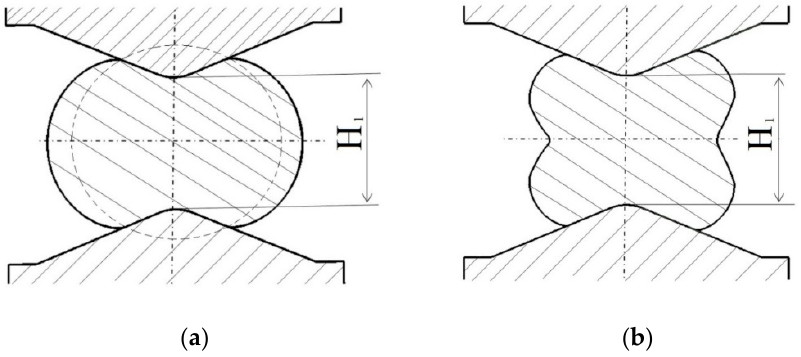
Figure 4. Order of forging the workpiece with convex anvils ( α c = 135°, 150°, and 165°), ( a ) after the first pass, ( b ) after the second pass.